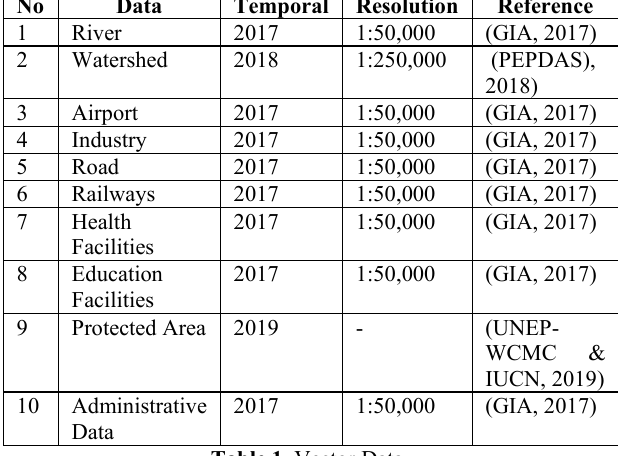
2.1.2 Raster Data Raster data consists of 12 remote